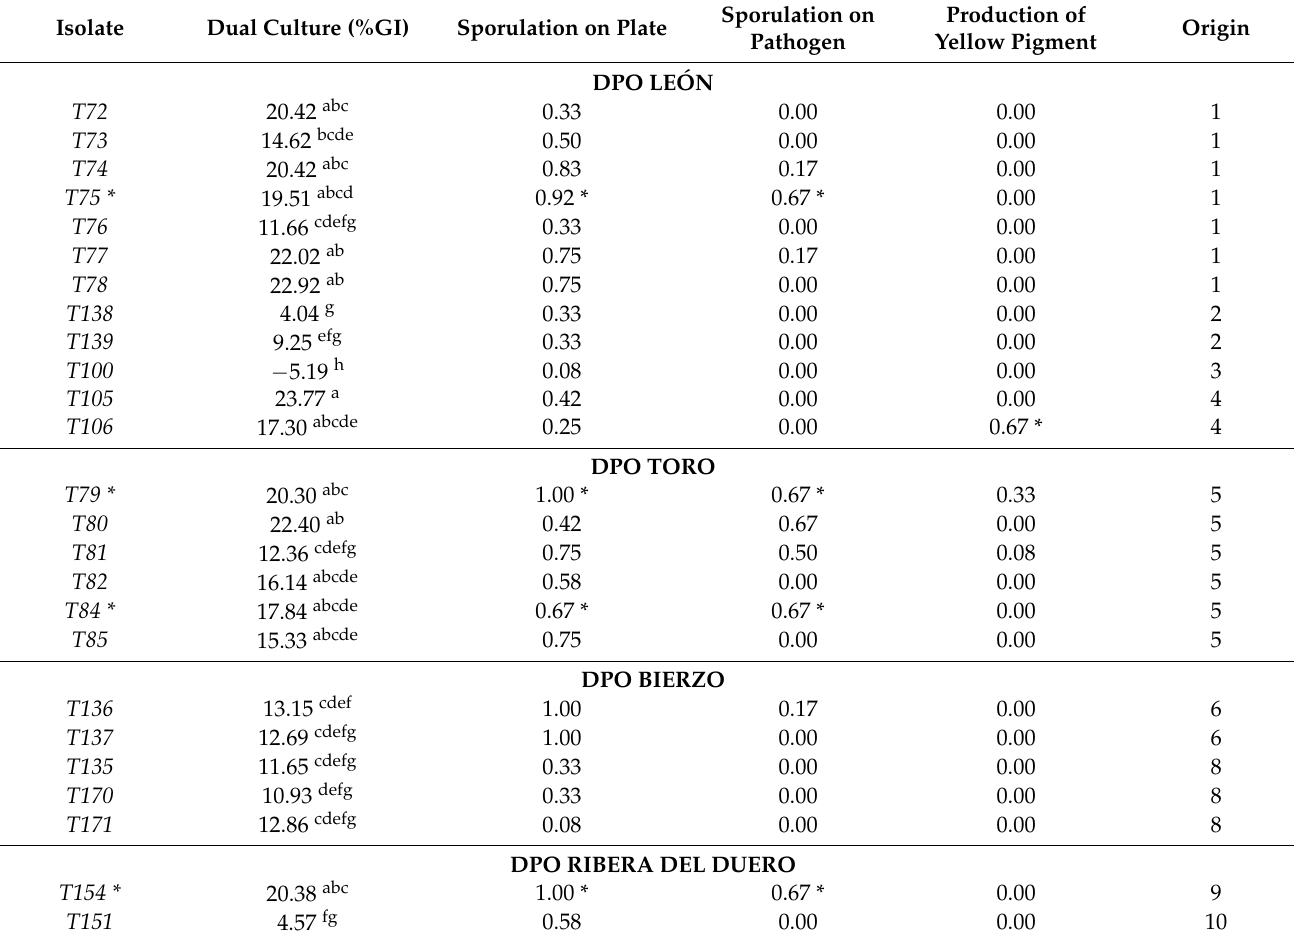
Table 4. Dual-culture assay of Trichoderma spp. isolates after 5 days at 25 ◦ C with the plant pathogenic fungi P. minimum on PDA. The letters indicate means within which there are no statistically significant differences ( p = 0.05), according to Tukey’s honestly significant difference (HSD) procedure applied to normalized data. An asterisk (*) indicates Trichoderma strain selected as potential biological control